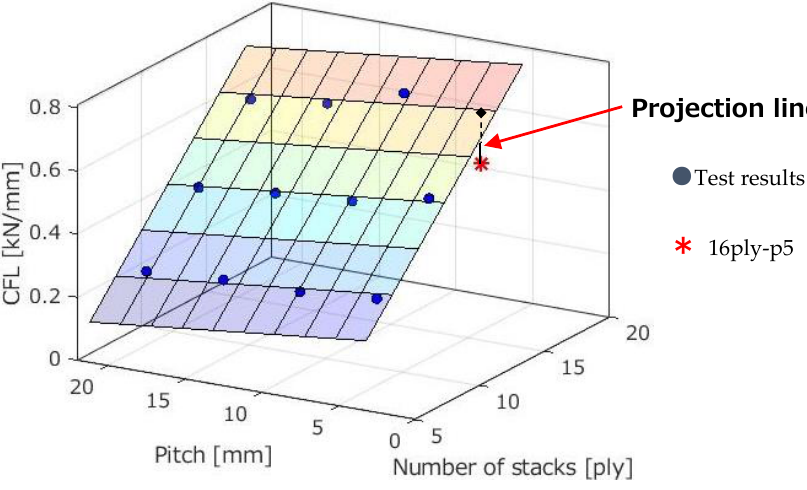
Figure 18. Response surface and test results (CFL).